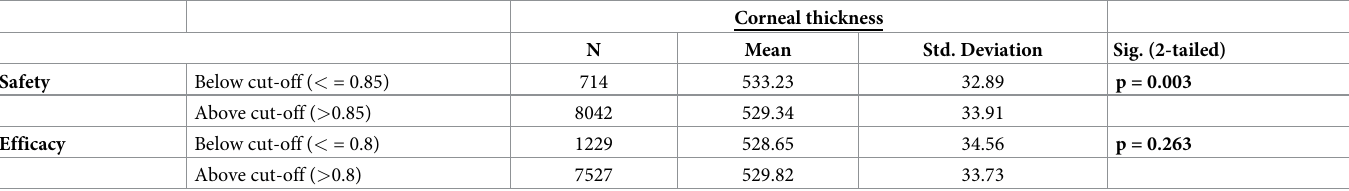
Table 8. Correlation between corneal thickness and safety and efficacy (T-Test).